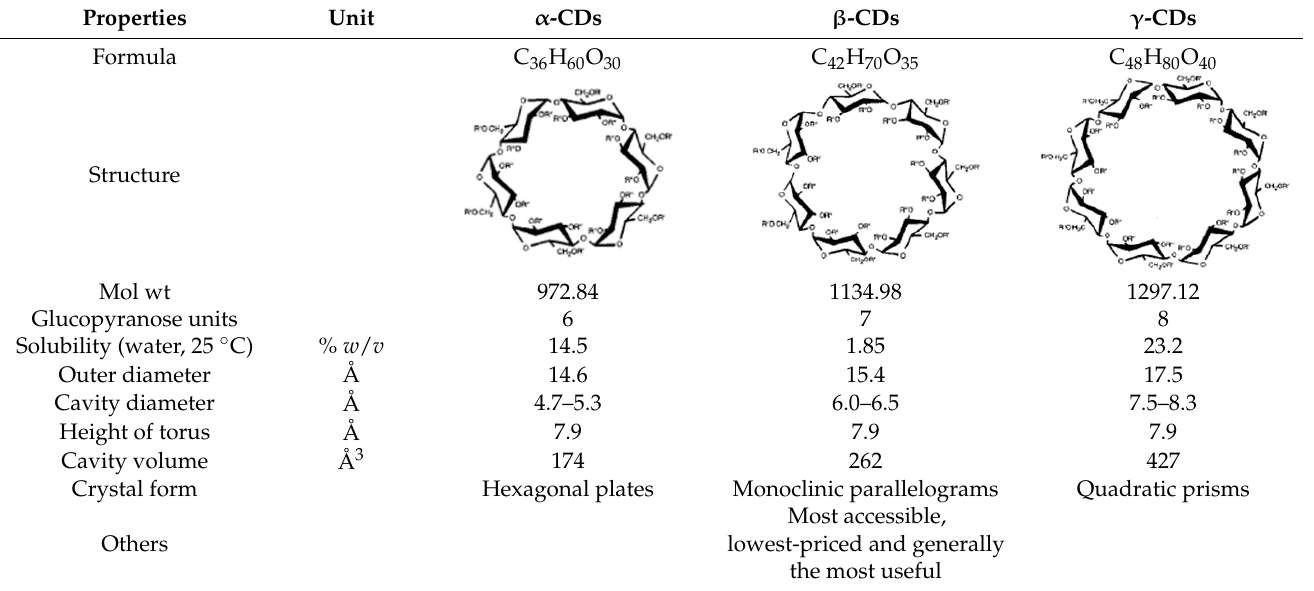
Table 1. Main cyclodextrins (CDs) properties [5,17].